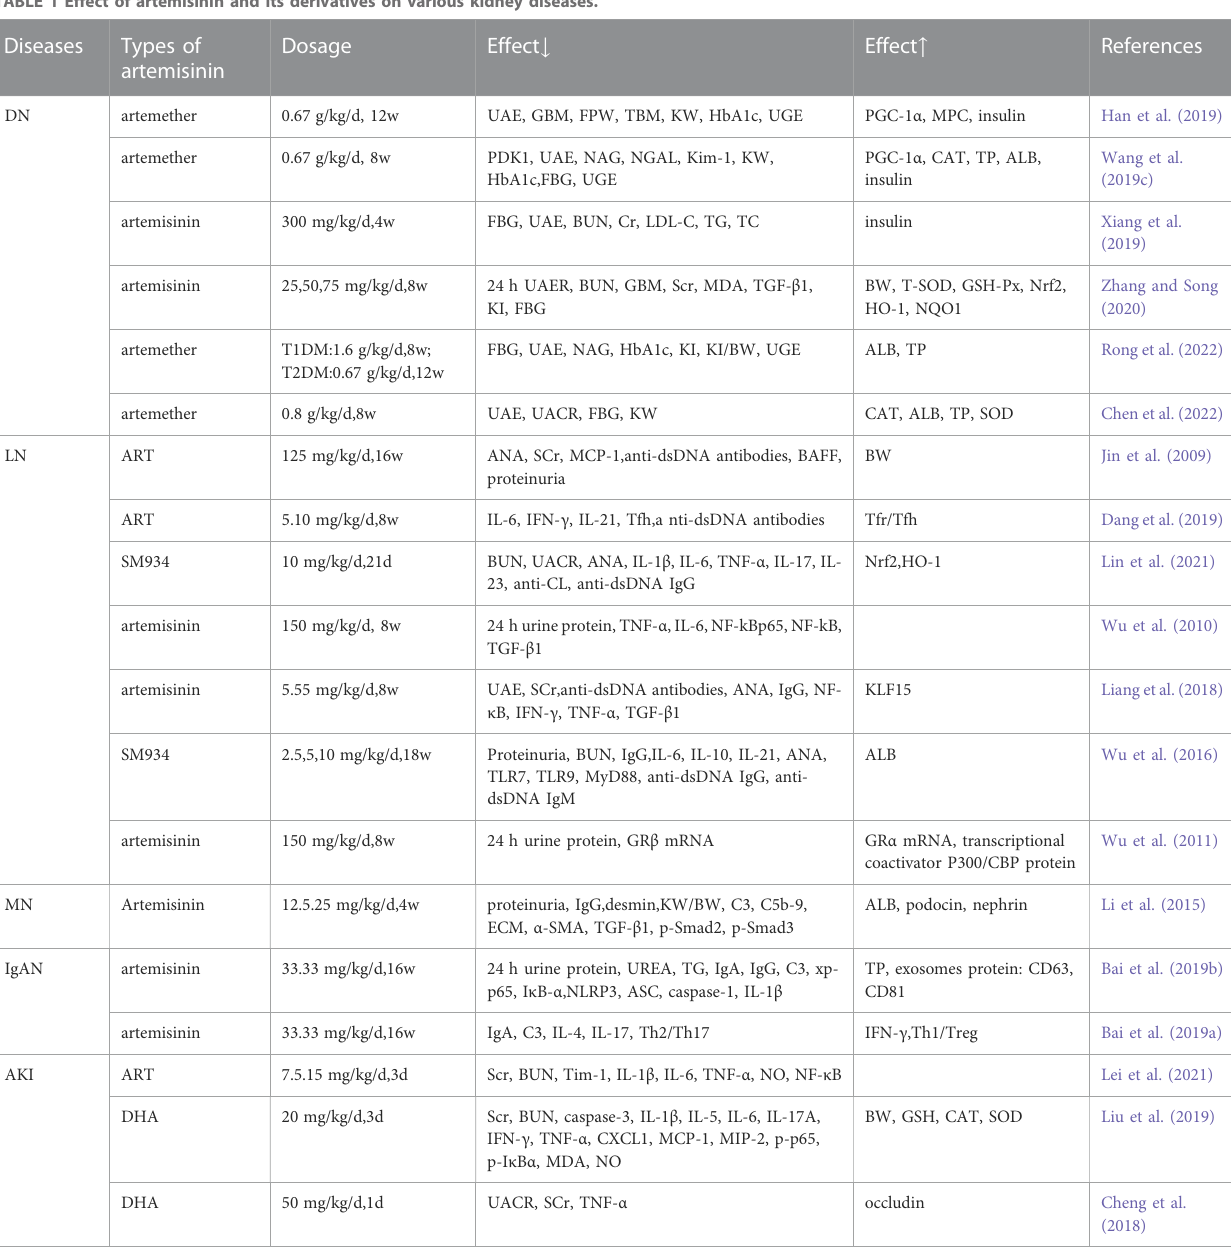
TABLE 1 Effect of artemisinin and its derivatives on various kidney diseases.